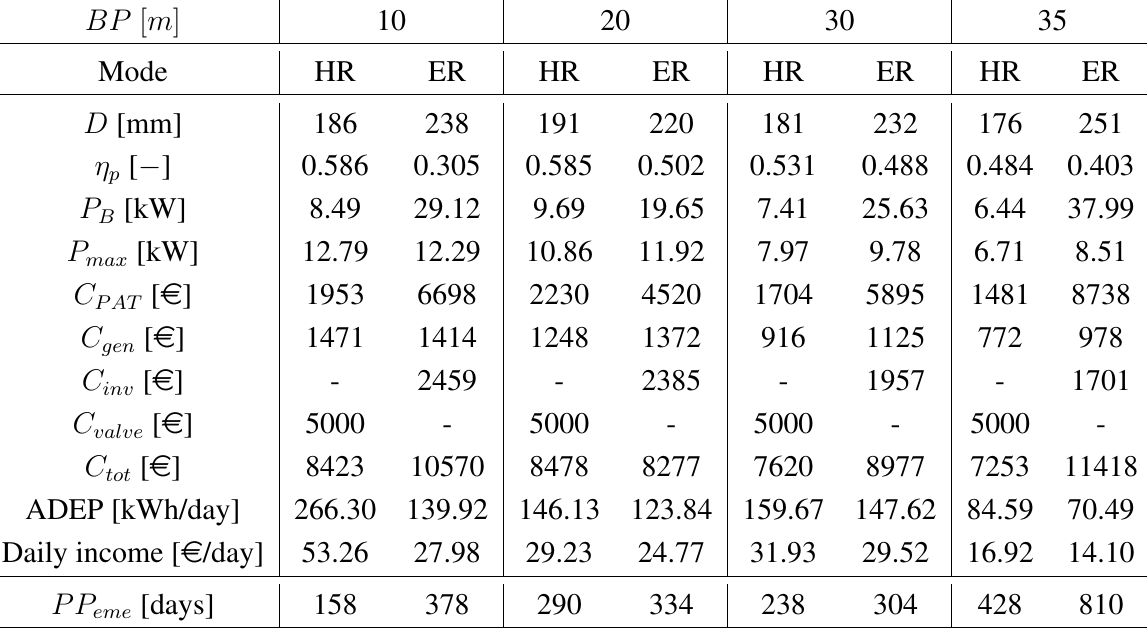
Table 4. Business plan and economic viability for HR and ER